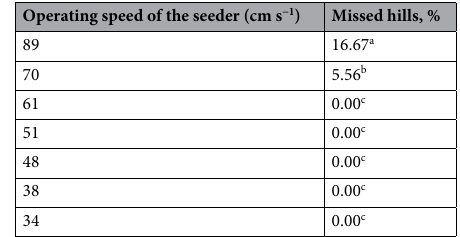
Table 7. Mean values missed hills in percent as affected by the levels of operating speed. Means of the same letter do not differ significantly at 5% level of